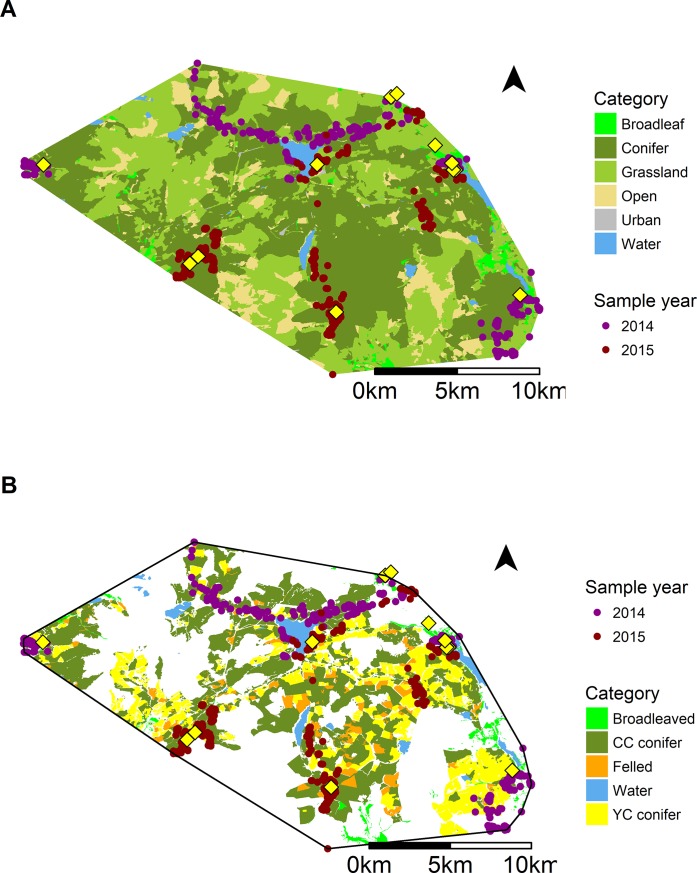
Total available habitat for P. pygmaeus (area inside minimum convex polygon formed around all fixes for all bats) and available habitat for (A) Broad resolution habitat map and (B) fine resolution forest management map. The white spaces on the fine resolution map indicate areas are upland, open areas which were not included in the fine scale analysis as the broad resolution analysis revealed very low use of these areas. Maternity roost locations for each bat indicated by a diamond. Tracking relocations are indicated by points.